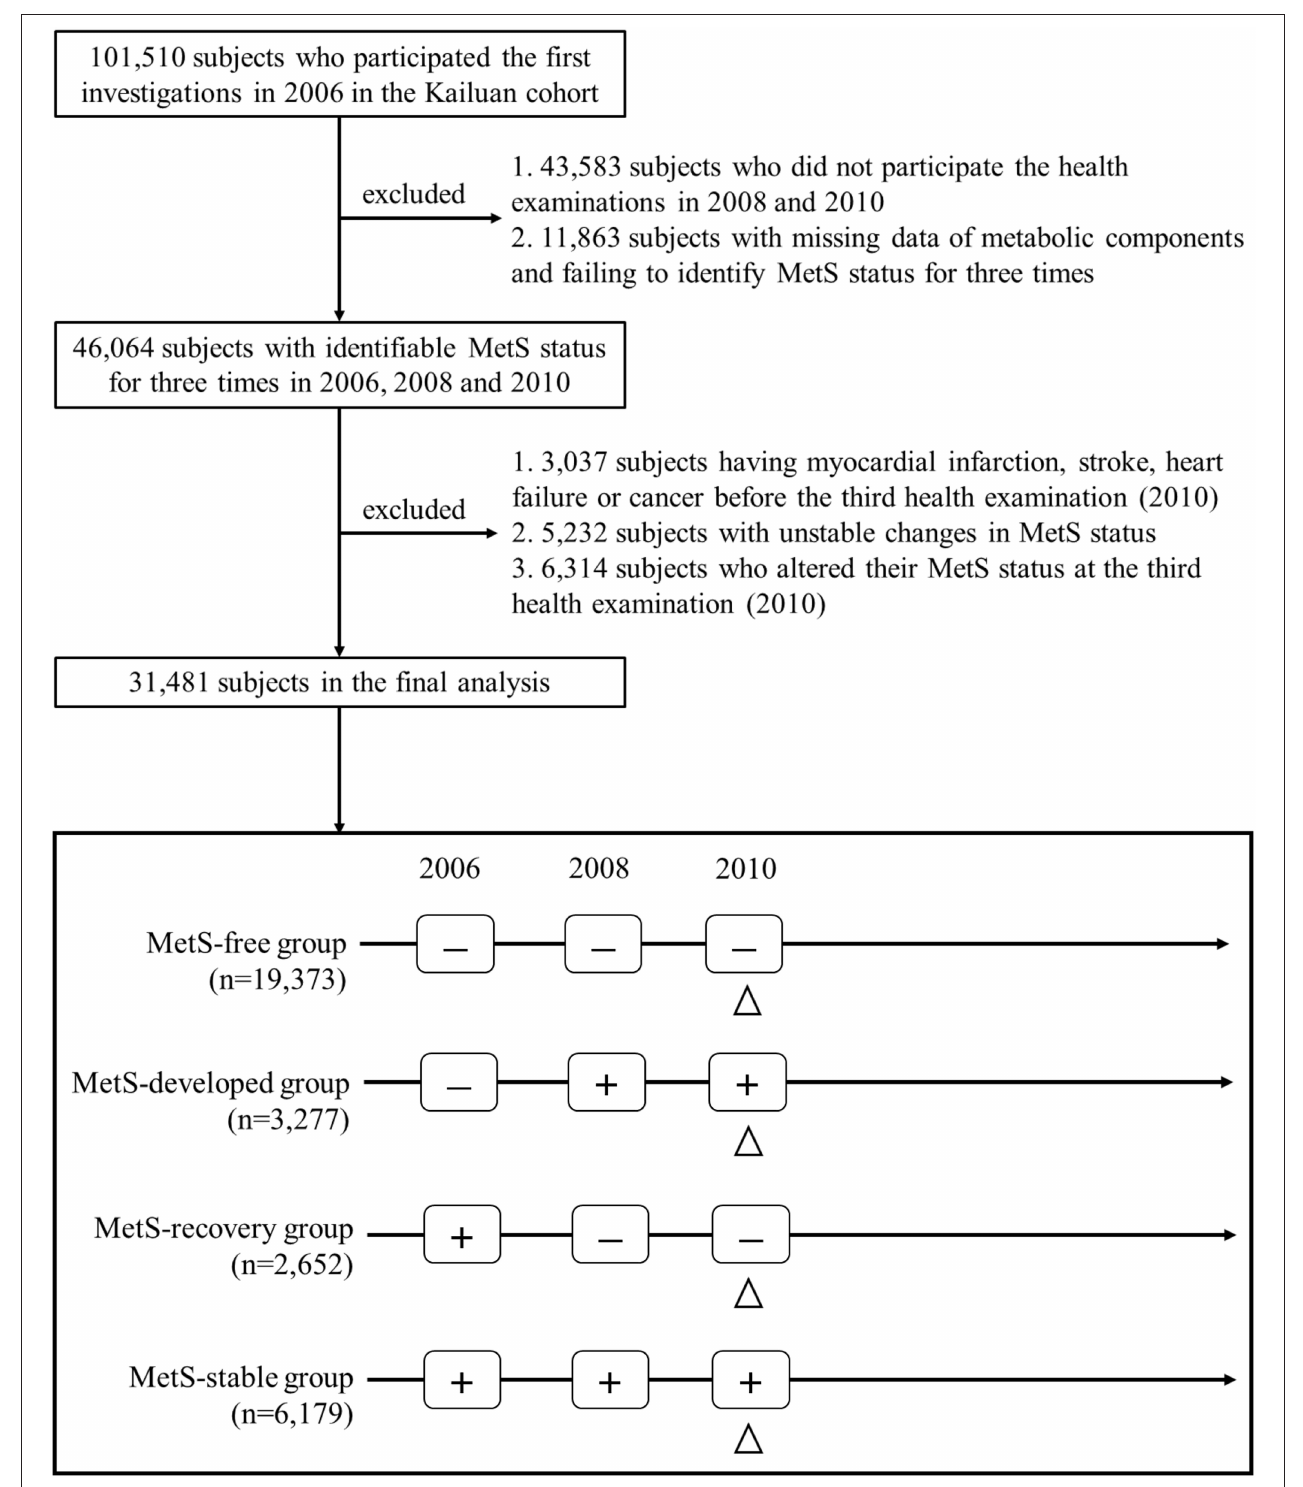
FIGURE 1 | Flowchart of the study population selection. The triangle indicated the initial time of follow-up for long-term outcomes. MetS, metabolic syndrome; “ + ,” MetS-present status; “-,” MetS-free status.